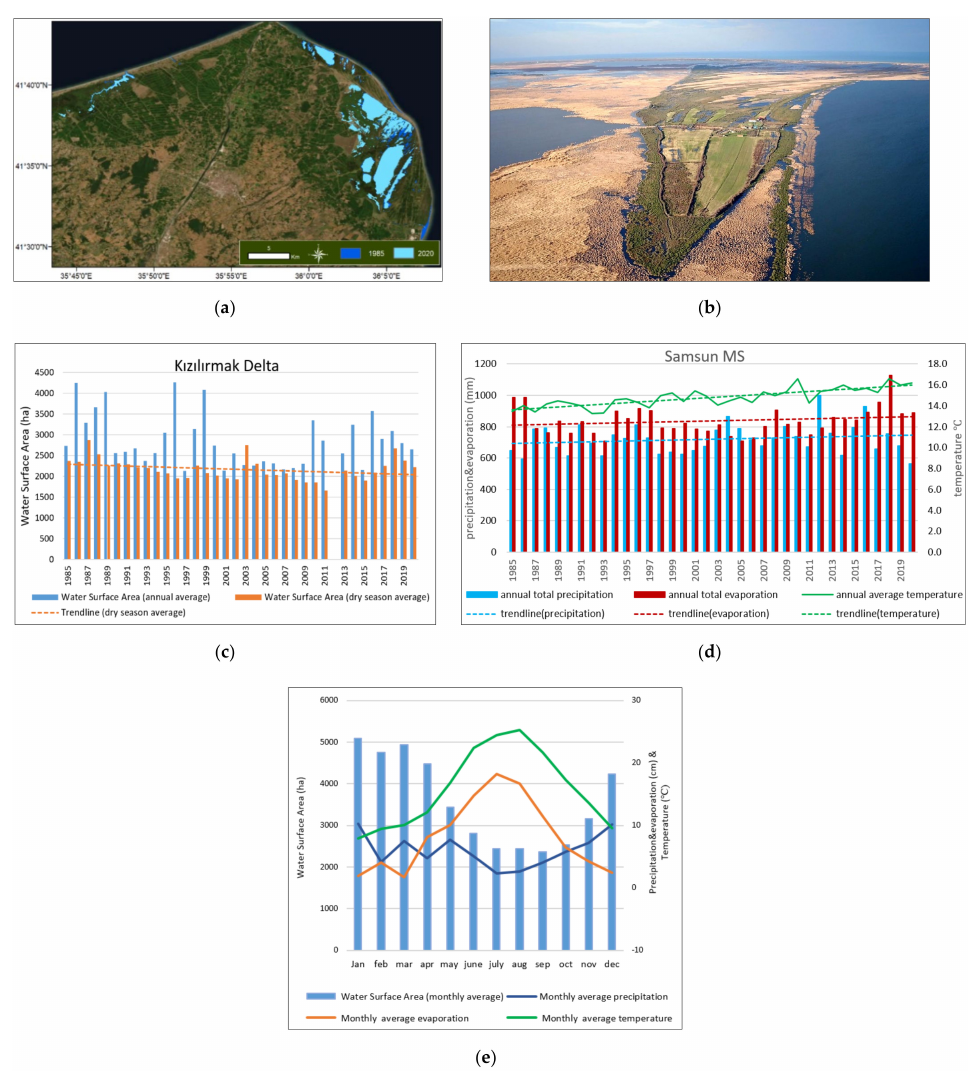
Figure 4. Kızılırmak Delta: ( a ) Location and 1985 and 2020 Annual Average Water Surface Areas (NDWI > 0); ( b ) View of Kızılırmak Delta [42]; ( c ) 1985-2020 Period, Water Surface Areas (Annual Averages and Dry Season Averages); ( d ) Samsun Meteorological Station Data (Annual Total Precip- itation, Total Evaporation, and Average Air Temperature); ( e ) 2016–2020, Monthly Average Water Surface Areas, Precipitation, Evaporation and